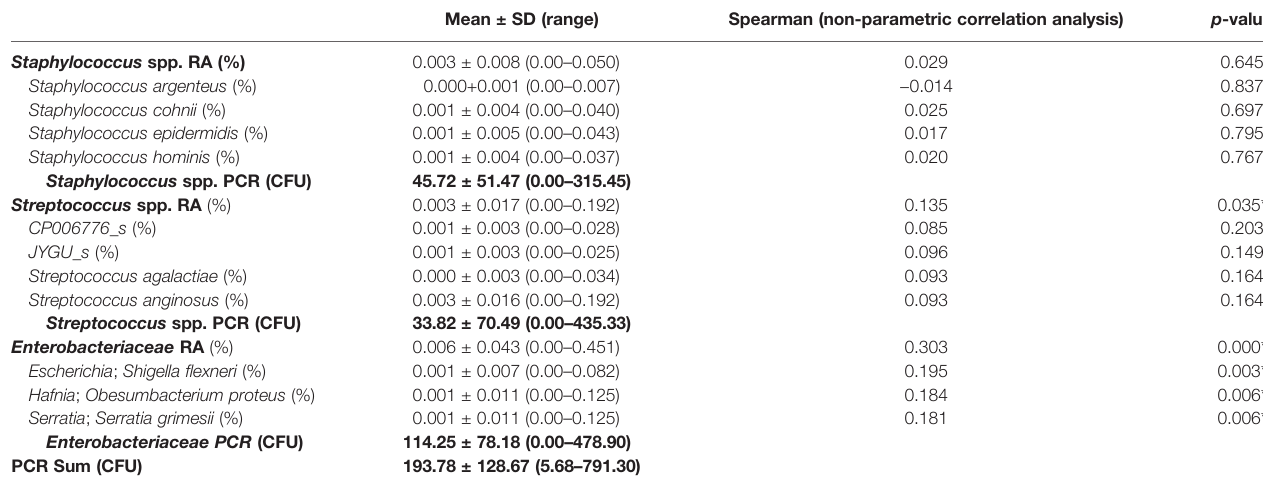
TABLE 3 | The correlation between the relative abundance (RA) of bacteria using metagenomics and the amount of bacteria using real-time